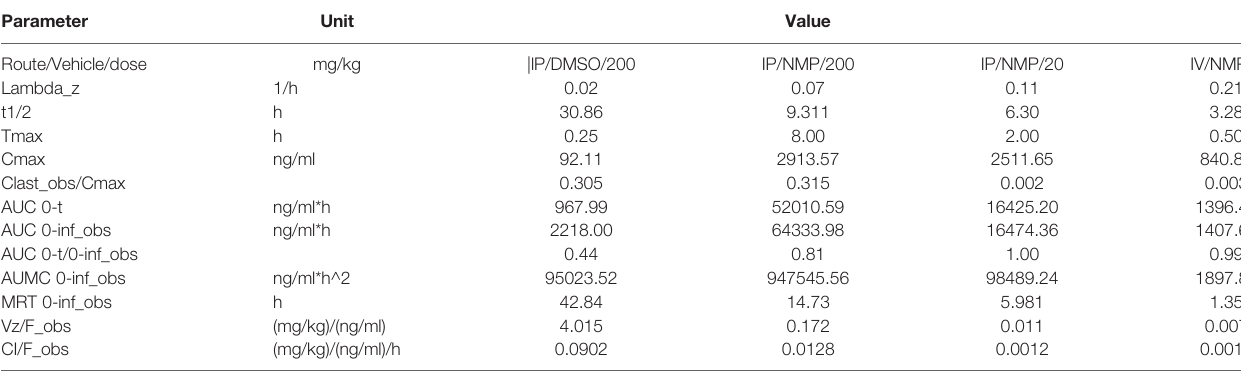
TABLE 4 | Pharmacokinetic analysis of 329